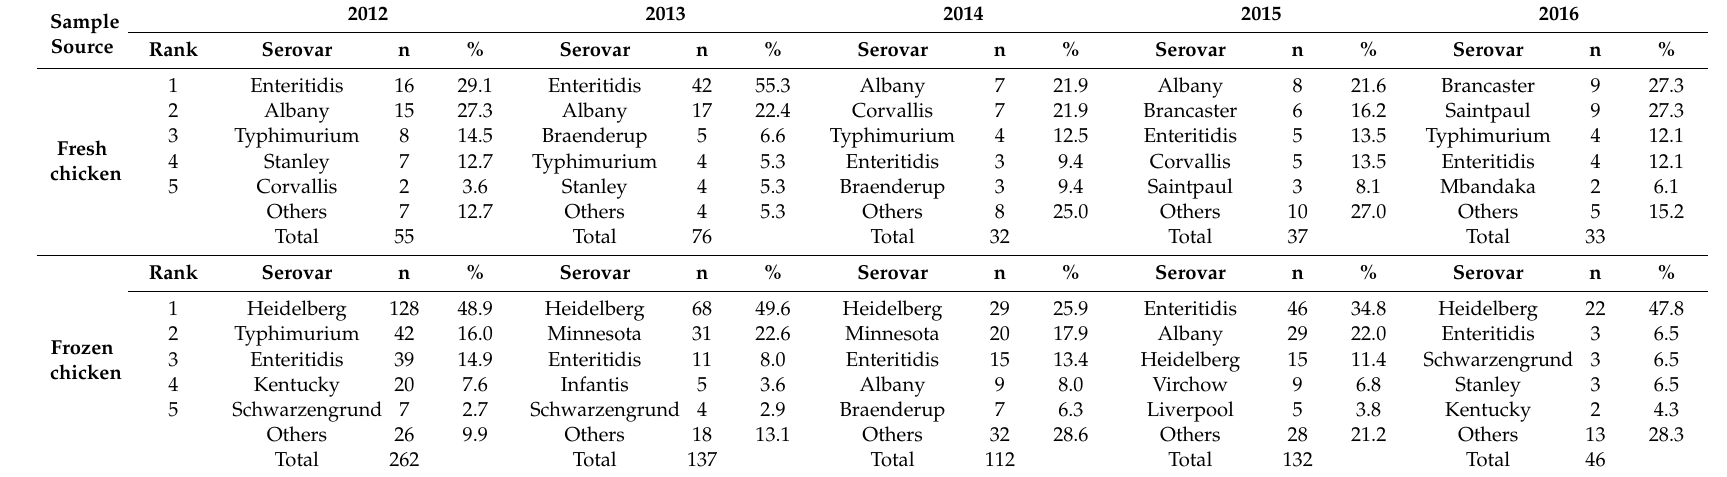
Table 4. Top five most common Salmonella serovars found in chicken samples from 2012 to